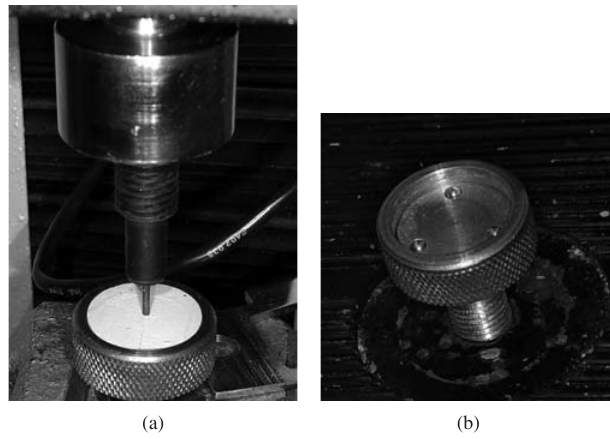
Figure 1. Mechanical apparatus used in indentation strength tests of ZTA disks